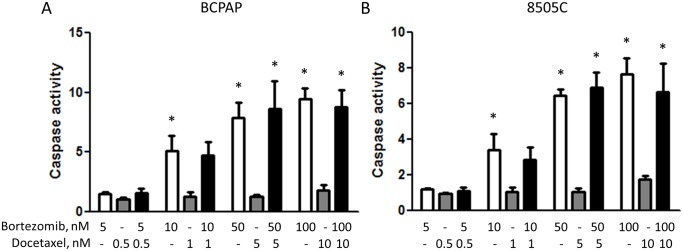
The caspase-3/7 activity is increased in BCPAP (A) and 8505C (B) thyroid cancer cells by bortezomib and a combination of bortezomib and docetaxel but not when treated with docetaxel alone.Asterisks point to a statistical significance when compared to a lowest dose group (p<0.05, one-way ANOVA, Newman-Keuls posttest).